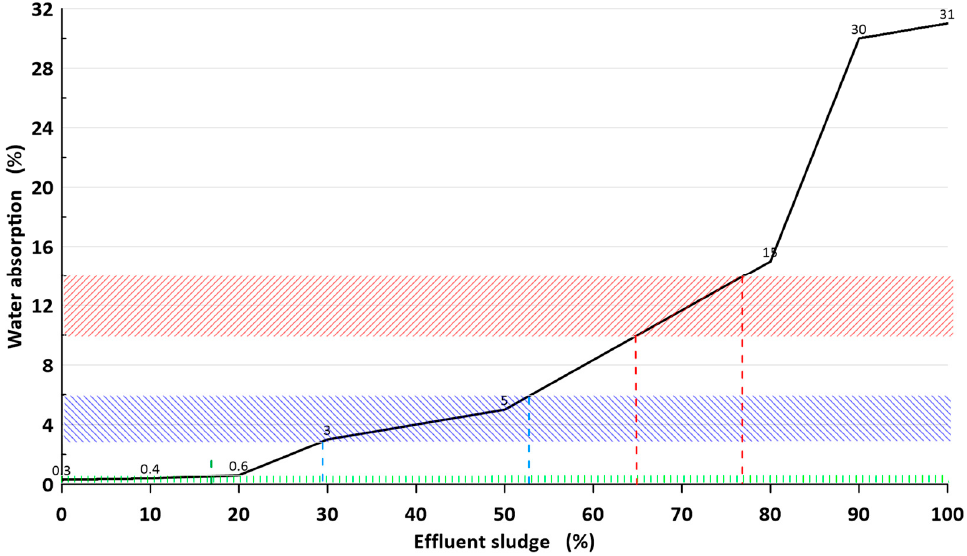
Figure 10. Influence of the sludge content in the lamellar mass on water absorption. Designation of area ranges as in Figure 8.